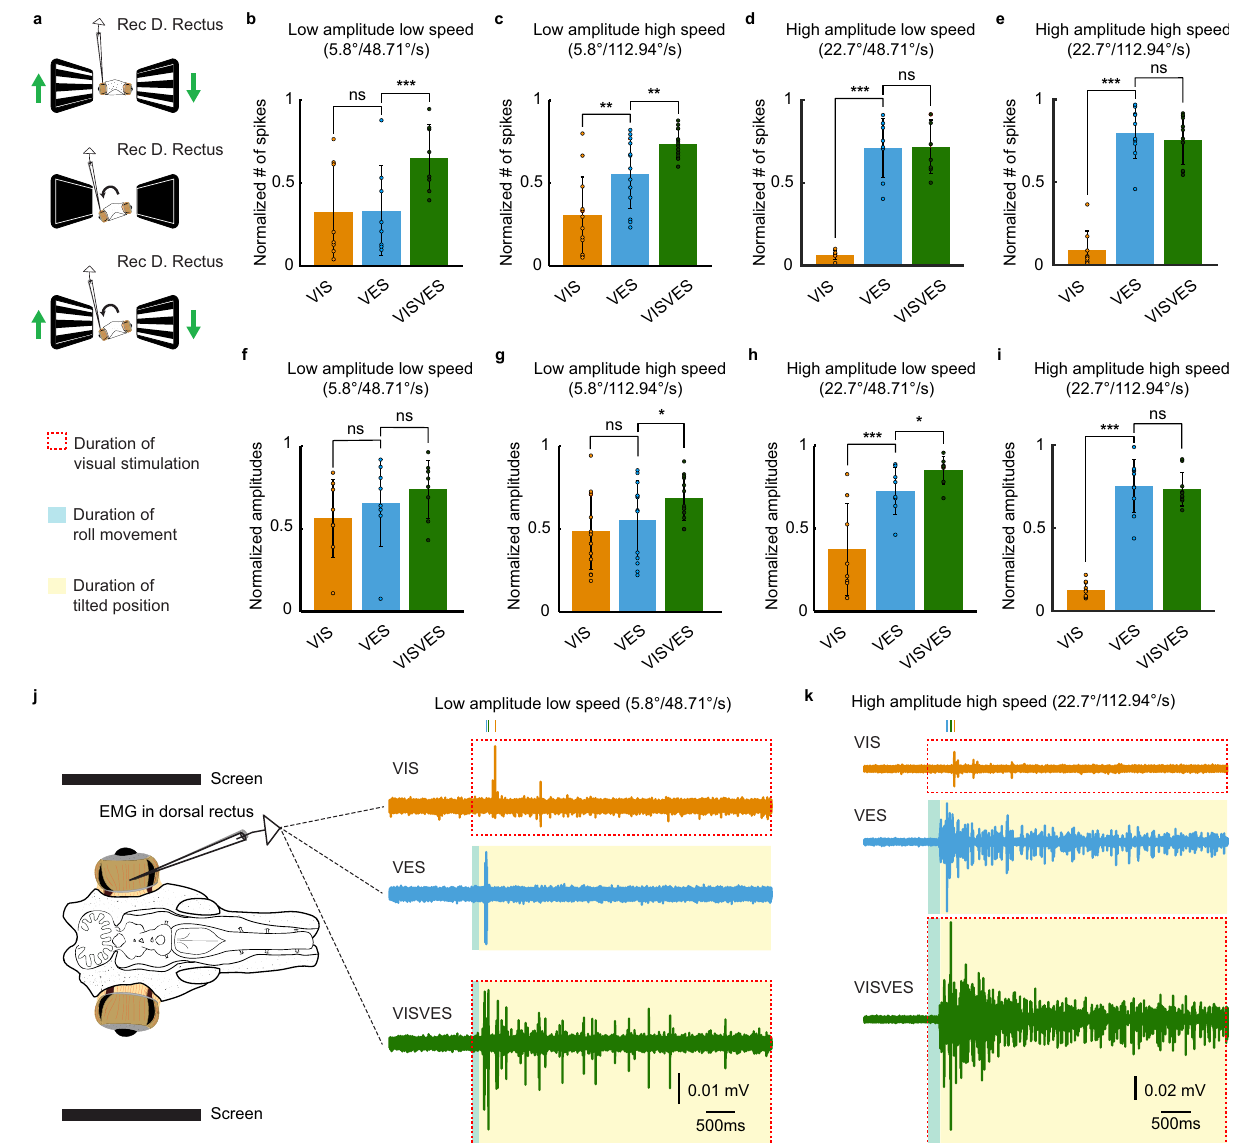
Fig.3|Impactofvisualandvestibularstimulioneyemovements.a Aschematic representation of the three experimental paradigms implemented: visual (top), vestibular (middle) and visuovestibular (bottom). Arrows indicate direction of sti- muli movement for both visual (green) and vestibular stimulation (black). A recording electrode was placed in the right dorsal rectus muscle. b – e Graphs showing EMG activity in terms of spikes number in response to visual (VIS), ves- tibular (VES), and visuovestibular (VISVES) stimulations during four different sti- mulation protocols in terms of amplitude and velocity. Amplitude refers to the peaktiltingangleoftheplatform,andspeedtothemotionvelocityoftheplatform or the visual stimulus. Signi fi cance between modalities is represented by stars in each graph and was retrieved through paired T -tests: Low amplitude low speed (VEStoVISVESt(23)= − 4.802, p <0.001; n =24recordingsfromeightanimals),Low amplitude high speed (VIS to VES t(36)= − 3.346, p =0.002 p =0.002 and VES to VISVES t(38)= − 2.930, p =0.006 p =0.006; n =37 recordings from 13 animals),